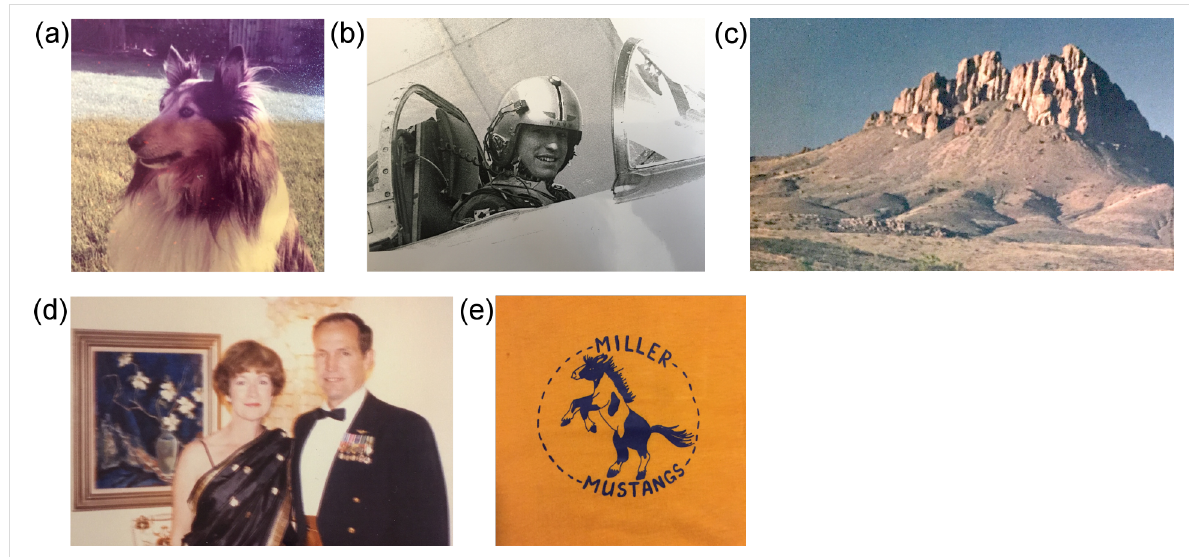
Figure 1: (a) Frodo the dog (copyright to MLW). (b) Ron Waters in an A6 in 1961 at the age of 26 (reproduced with permission from RLW). (c) A picture of Steeple Rock, near Duncan, AZ where we spent many mornings collecting geodes when visiting my grandparents (reproduced with permis- sion from RLW). (d) Sue and Ron Waters in front of a painting by Sue Waters in 1983 (reproduced with permission from ASW and RLW). (e) My first successful artwork – the school logo I designed in elementary school (reproduced with permission from Miller Elementary School).